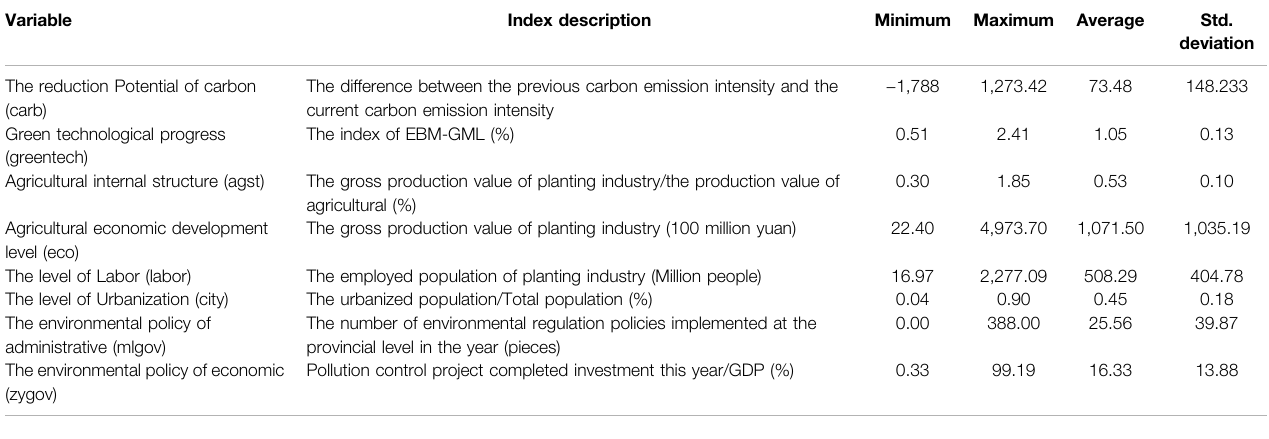
TABLE 1 | Descriptive statistics of related variables.